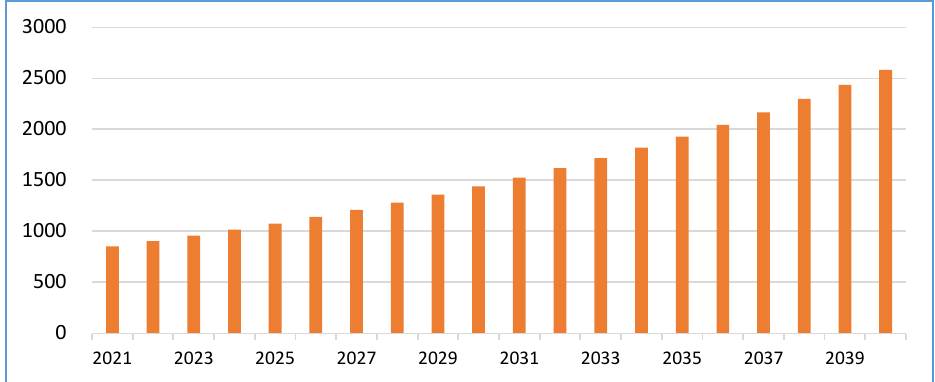
Figure 9. 2021–2040 domestic sales market output value forecast (CNY 100 million).